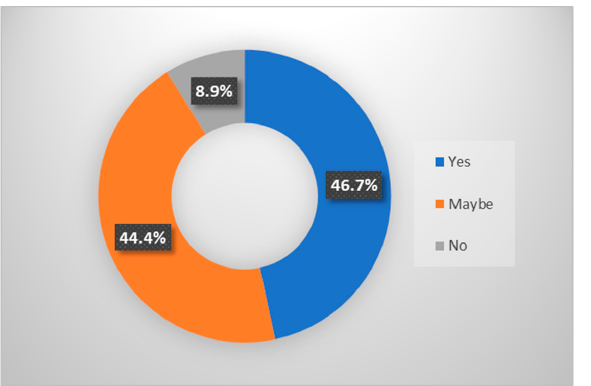
Figure 1. Pupils’ intention to use a mobile application in order to obtain a more sustainable travel behavior.